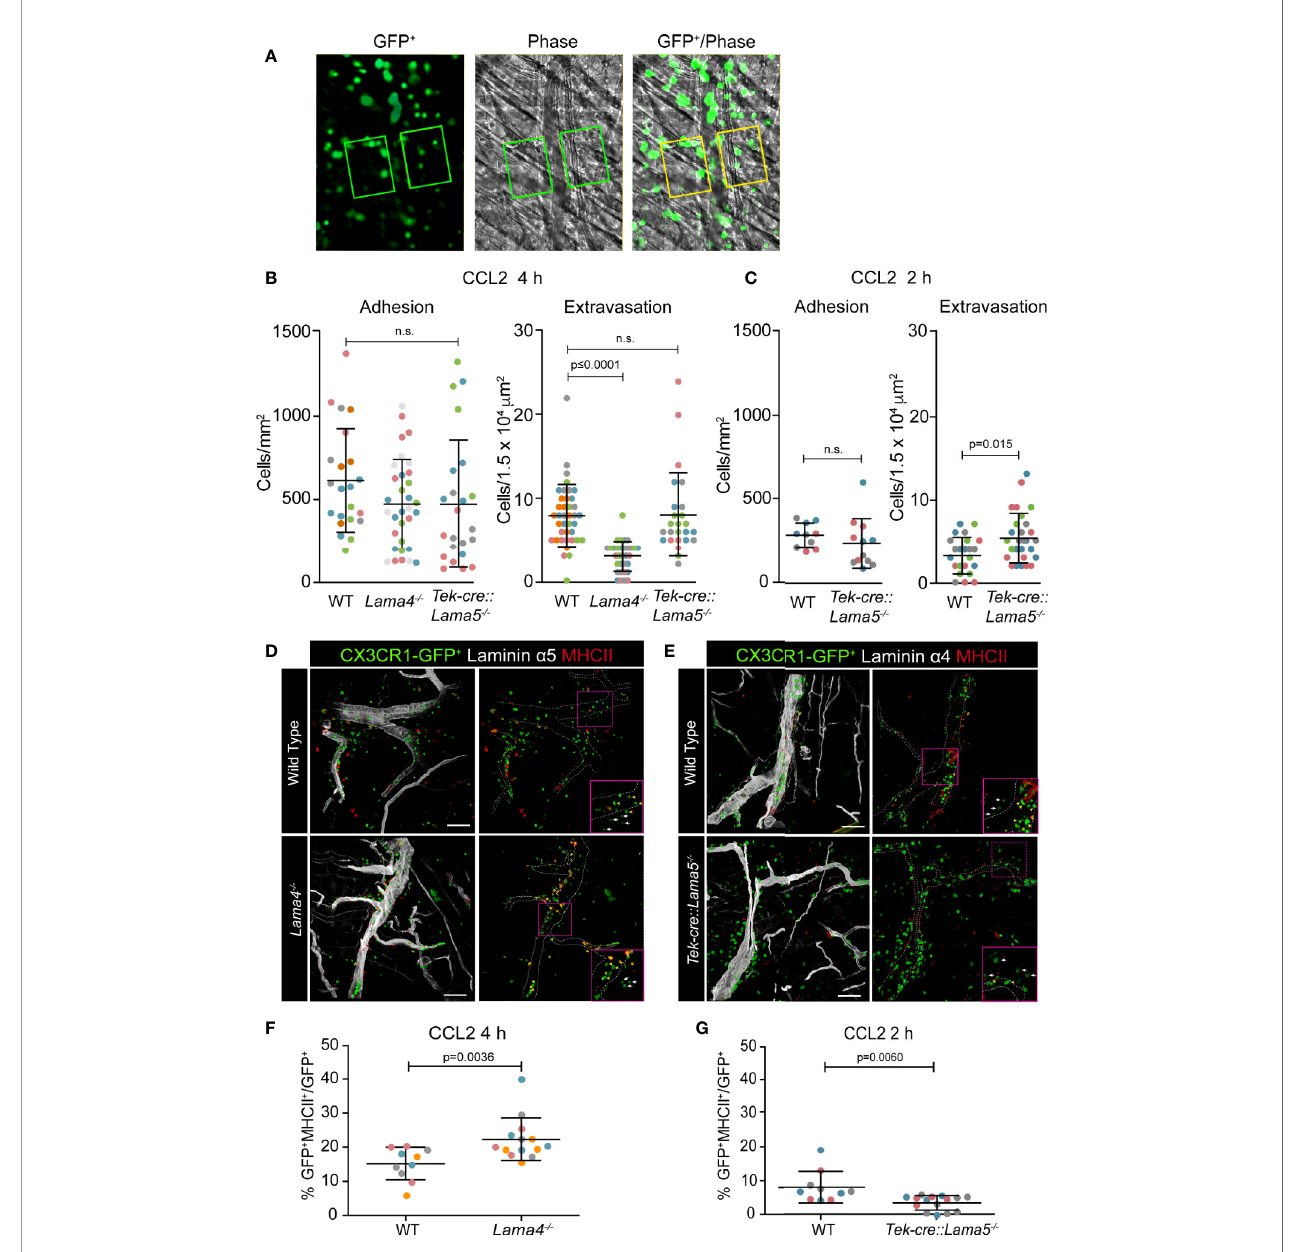
FIGURE 1 | Intravital microscopy of CCL-2 induced monocyte extravasation in cremaster muscle postcapillary venules of Lama4 − / − or Tek-cre::Lama5 − / − hosts carrying CX3CR1 GFP/+ bone marrow. (A) Representative fl uorescence and corresponding phase contrast images from movies of CX3CR1-GFP + cells extravasating across postcapillary venules of the cremaster muscle; boxed areas, extending from the border to 75 m m either side of postcapillary venules for a length of 100 m m, were used to quantify extravasated CX3CR1-GFP + cells; scale bars = 50 m m; n.s. = non-signi fi cant. Quanti fi cation of adherent and extravasating CX3CR1-GFP + monocytes at (B) 4 h and/or (C) 2 h post-application of CCL2. Data are means ± SD from fi ve WT mice and four mice for each chimera with four to eight postcapillary venules examined/mouse at 4 h and three to four WT and chimeric mice with three to four postcapillary venules examined/mouse at 2 h. (D, E) Excised tissues were immuno fl uorescently stained for MHCII and laminin a 5 or a 4 to identify CX3CR1-GFP + MHCII + extravasating cells in relation to the endothelial basement membrane; dotted lines denote vessel borders; boxed areas are shown in inserts in the lower right hand corners at high magni fi cations to illustrate patrolling (yellow arrowheads) versus in fl ammatory monocytes (white arrows); scale bars = 50 m m. (F, G) Quanti fi cation of proportions of CX3CR1-GFP + MHCII + cells expressed as percentage of total GFP + cells in Lama4 − / − or Tek-cre::Lama5 − / − hosts. Data are means ± SD from four WT and four chimeric mice with two to four postcapillary venules examined/mouse in (F) and three WT and three chimeric mice with three to seven postcapillary venules examined/mouse in (G) . In (B, C, F, G) each dot or square denotes one mouse and the different experiments are marked by different colors; signi fi cance was calculated using Mann-Whitney tests as not all data passed the normality test by D`Agostino & Pearson; the exact p -values are shown in the